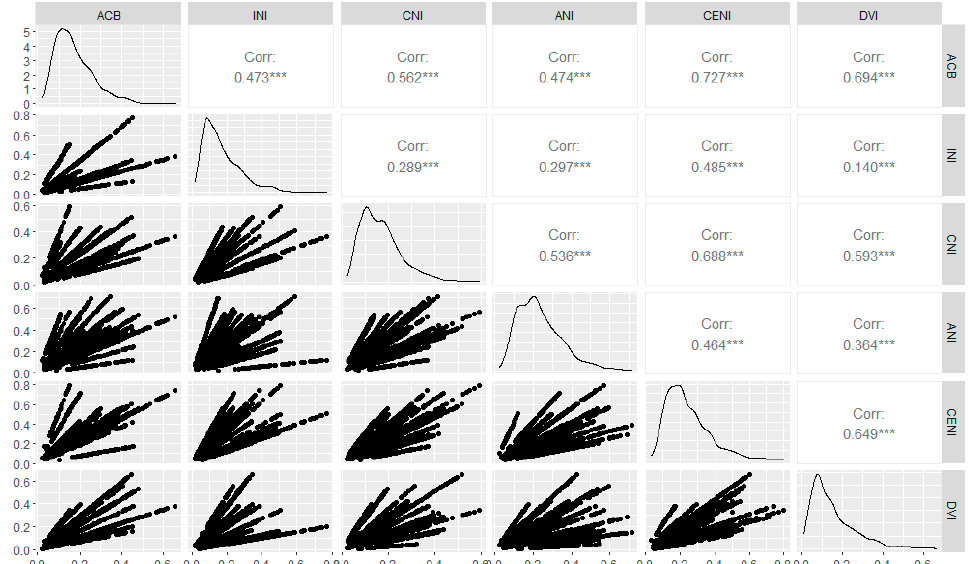
Figure 5. Correlation matrix between RPF factors and Composite Index of Online Purchasing Behavior as of June 2020. Source: developed by the authors. *** p ≤ 0.001.